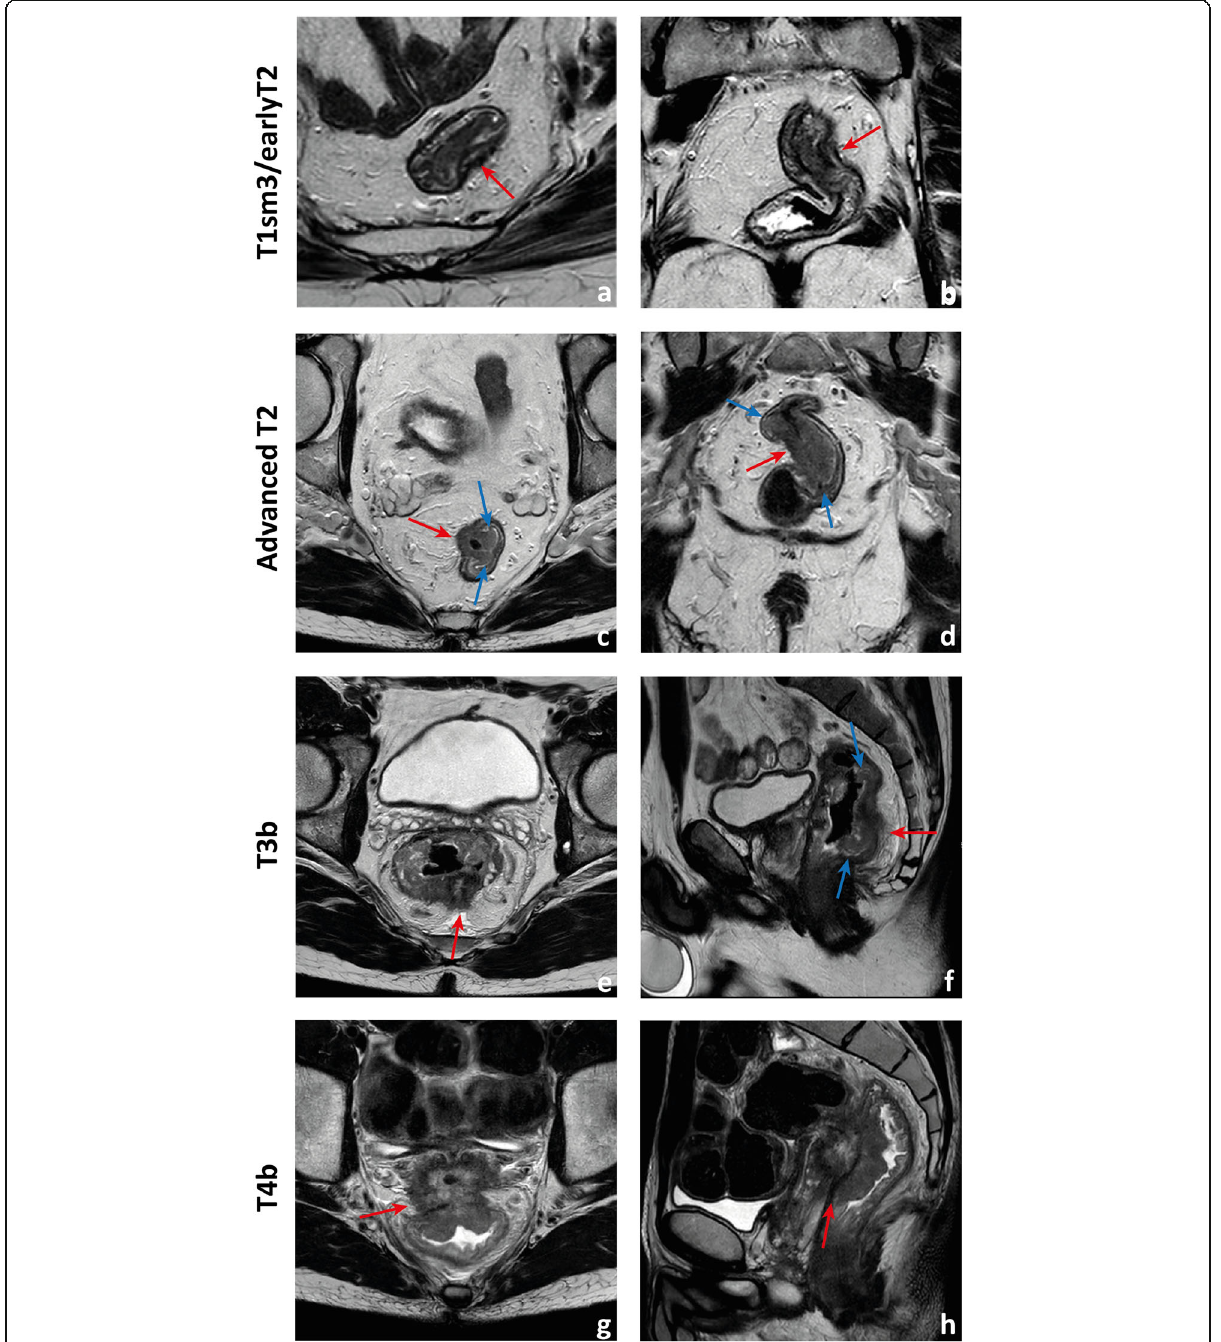
Fig. 12 Examples of differently T-staged tumours. a , b Arrows point to an early polypoid tumour occupying the full depth of the submucosa centrally and therefore staged clinically as mrT1sm3/early T2. Total mesorectal excision was performed, and at pathology, it corresponded to a T1sm3. c , d This ulcerated tumour extends in depth through the full thickness of the muscularis propria and was therefore staged as an MR advanced T2 (red arrows), which was confirmed at pathology. Notice how the periphery of the tumour overhangs the rectal wall both in the axial and coronal planes (blue arrows). e , f This mid-high, sub-circumferential rectal cancer extends 4 mm into the mesorectal fat at its most central area (red arrows) and was therefore staged as T3b. Notice the overhanging edges on the sagittal plane (blue arrows in f ). g , h An anterior mid- high rectal cancer crosses the Denonvillier fascia and the peritoneal reflection to invade the seminal vesicles in this male patient, corresponding to an mrT4b. The patient underwent chemoradiation and is currently under palliative treatment due to distant metastatic